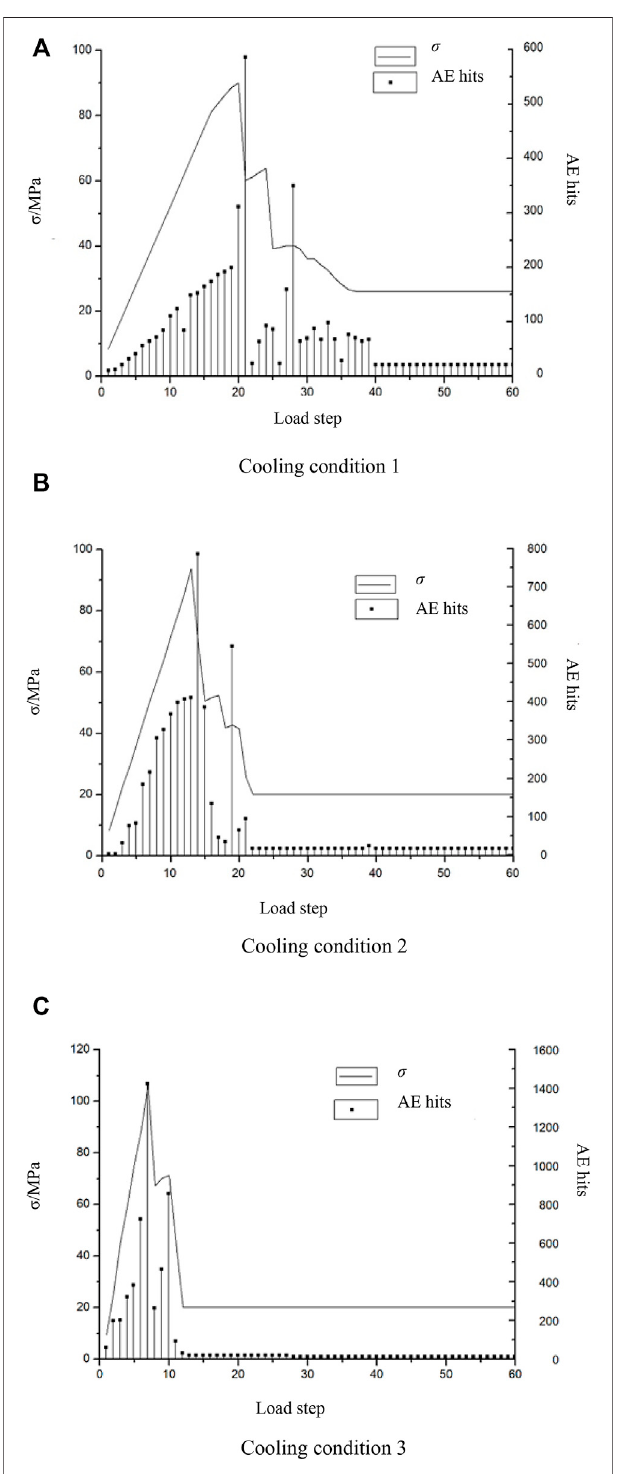
FIGURE 3 | Load step – σ – AE curves under three cooling conditions. (A) Cooling condition 1, (B) Cooling condition 2, and (C) Cooling condition 3.